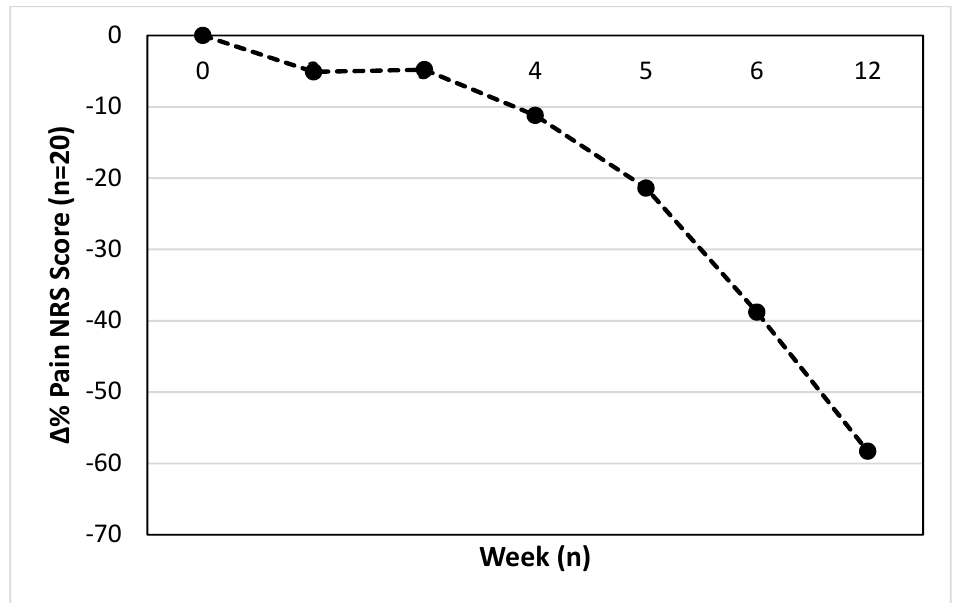
Figure 2. Relative percentage change in mean (week 2–6) or median (week 12) pain score from week 1. Figure 3 displays mean or median and individual relative percent change in pain scores at the end point of the study (week-6) and at the 12-week follow up point. Mean and median pain scores were statistically lower at week-6 ( − 38.8%, 95% CI: − 28.7– − 48.8%, range: − 85.4–3.7%) and week-12 (58.3%, 95% CI: − 40.0– − 96%, range − 100–96%), respec- tively.